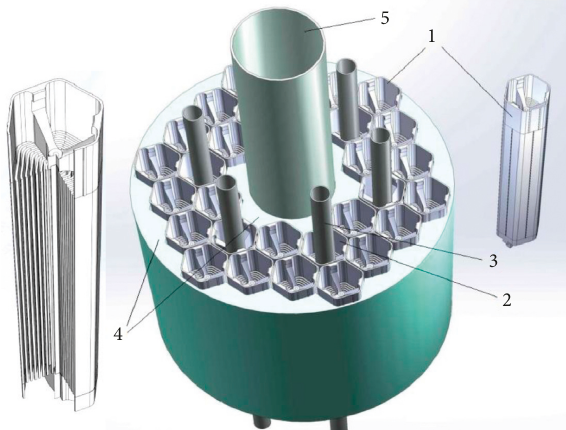
Figure 2: 3D model of the reactor core: (1) 8-pipe fuel asemblies of the VVR-KN type; (2) 5-pipe fuel assemblies of the VVR-KN type; (3) CPS channel; (4) displacer; (5) central retarding (ii) Bottom flow section diameter of 12.6 m (iii) Upper flow section diameter at the top of 10.4 m